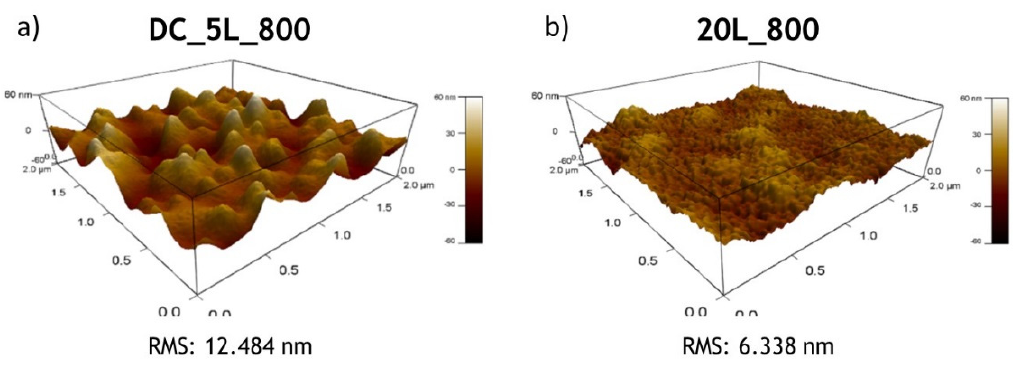
Figure 4. AFM images and root mean square (RMS) factors for the ( a ) DC_5L_800 and ( b ) 20L_800 films.